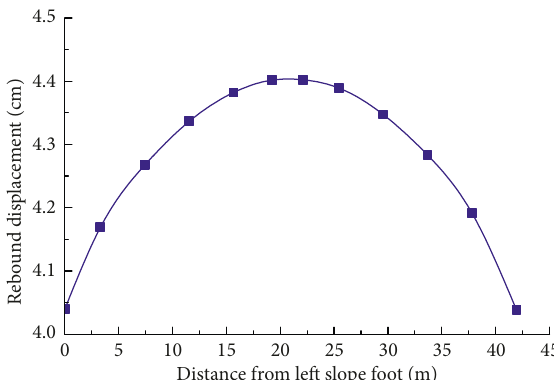
Figure 14: Rebound displacement of trench